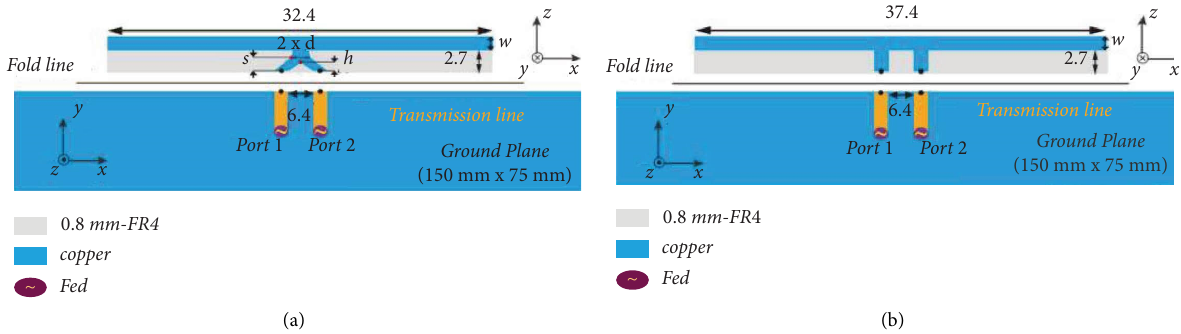
Figure 2: Geometry of. (a) Te proposed dual-port microstrip antenna pair fed by a similar π -shaped feeding structure. (b) Te compared dual microstrip antenna pair fed by a feeding structure with connecting line (unit: